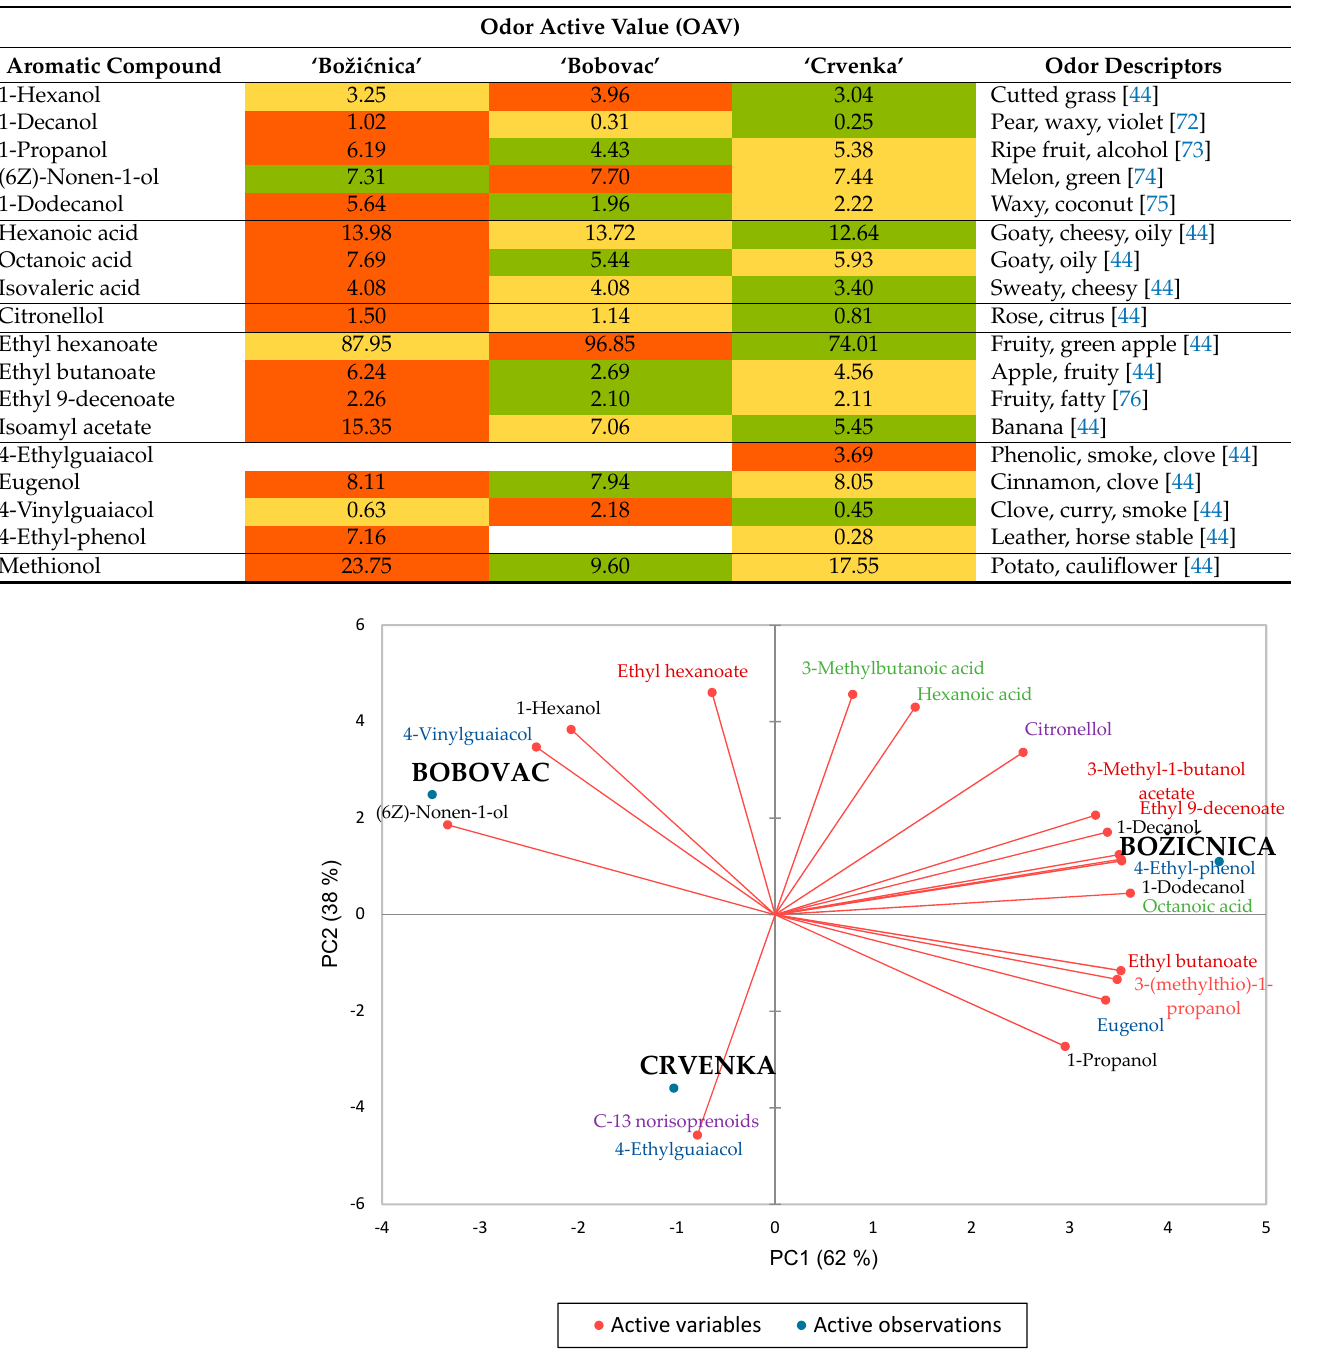
Figure 2. Principle component analysis (PCA): Distribution of P é t-Nat ciders from three apple varieties in two-dimensional coordinate system defined by the first two principal components (PC1 and PC2) according to aromatic compounds contents with OAV >1.